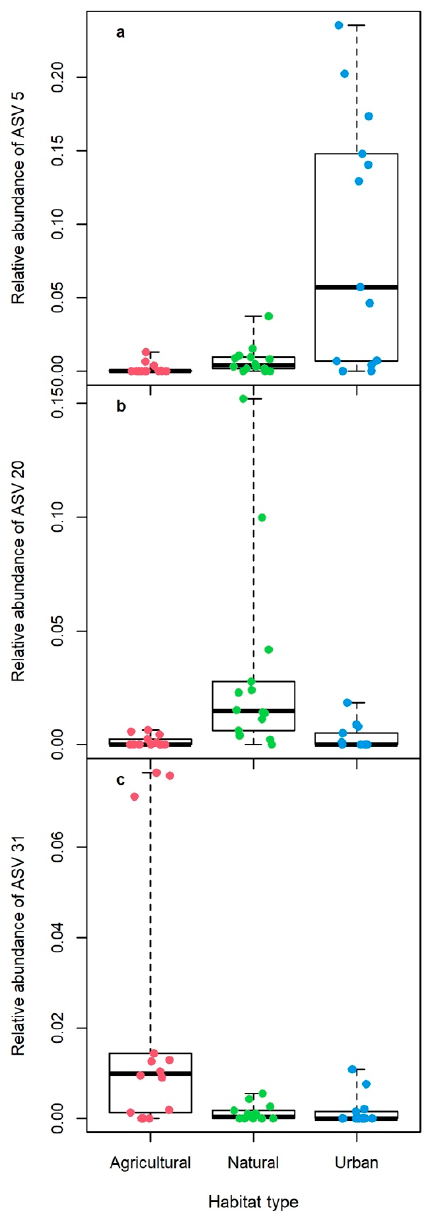
Figure 3. Relative abundance of the three most common ASVs that differed the most across habitat type: ( a ) ASV 5 from the genus Desulfovibrio (phylum Desulfobacterota, class Desulfovibrionia, order Desulfovibrionales, family Desulfovibrionaceae), ( b ) ASV 20 from family Sutterellaceae (phylum Proteobacteria, class Gammaproteobacteria, order Burkholderiales), and ( c ) ASV 31 from Rs-E47 termite group (phylum Bacteroidota, class Bacteroidia, order Bacteroidales). Colored dots represent individual tadpoles from each habitat type (natural: green, agricultural: red, urban: blue); boxplots show the median (thick line), interquartile range (box), and data range